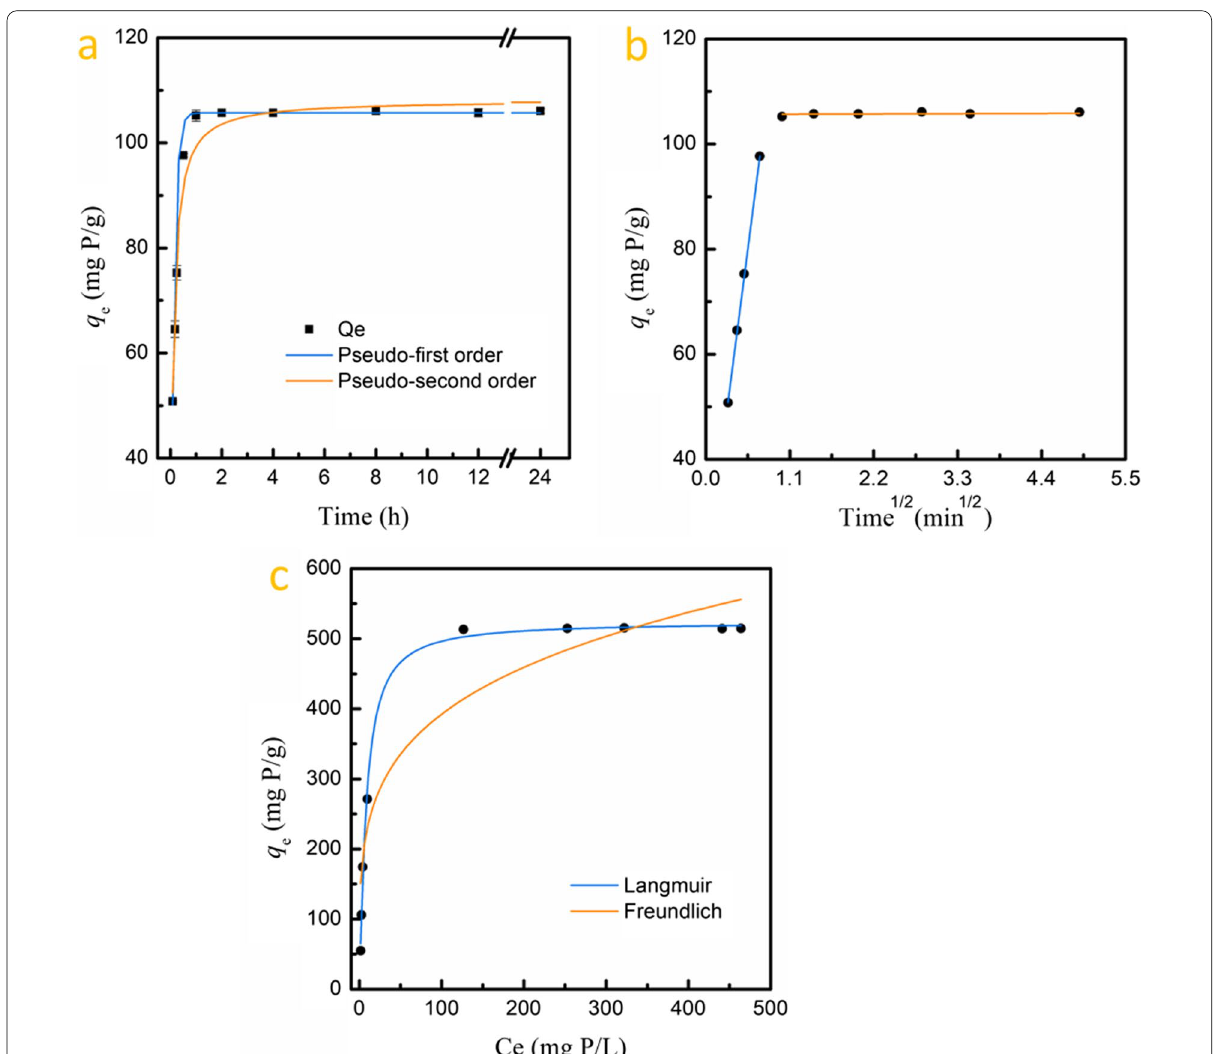
Fig. 3 Effect of contact time on P adsorption by the MFBC and data modelling with a the pseudo-first-order and pseudo-second-order kinetic models and b intraparticle diffusion model, c effect of initial P concentration on the adsorption and experimental data fitting using the adsorption isotherm